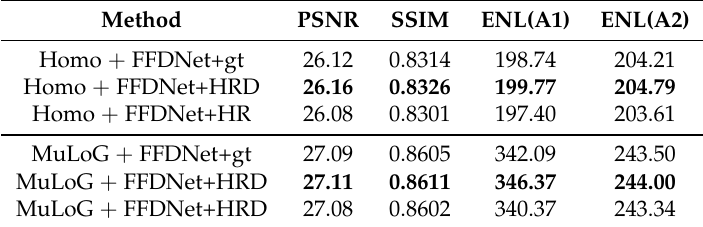
Figure 19. The values of the number of looks L in different ways. Table 9. The quantitative comparison of different methods for simulated SAR image with L = 1.